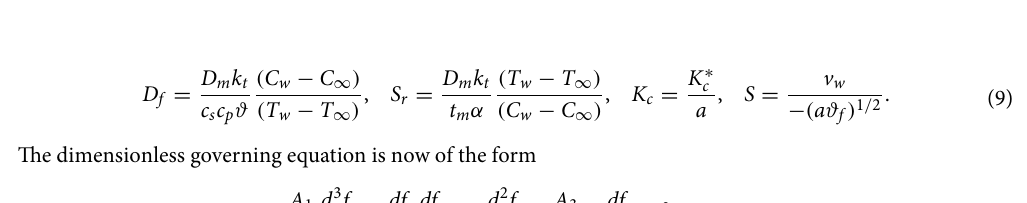
Table 1. Comparison of 0 L e D f = =